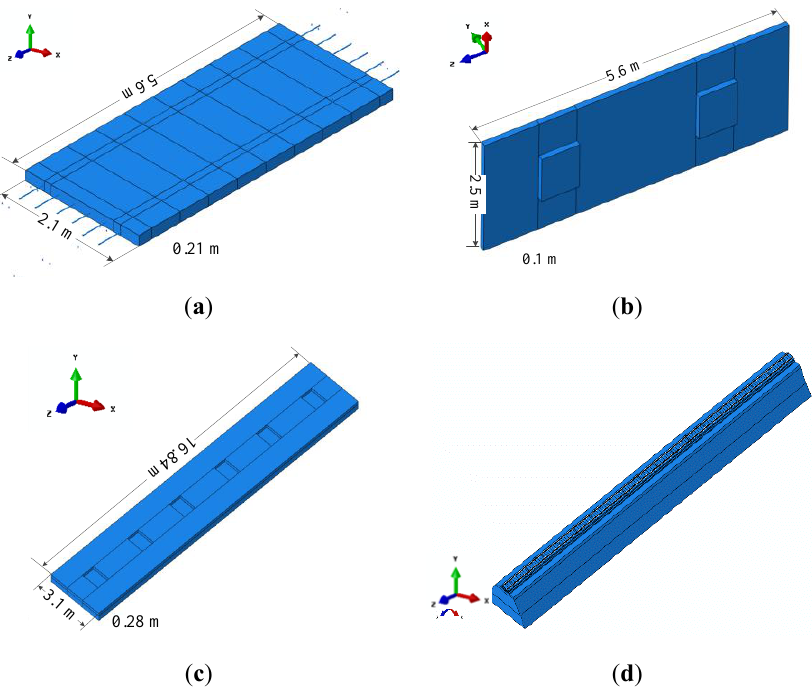
Figure 8. CRTSIII unballasted track division structure and overall structure. ( a ) Track slab structure, ( b ) self-compacting concrete layer structure, ( c ) base structure, ( d ) overall structure.